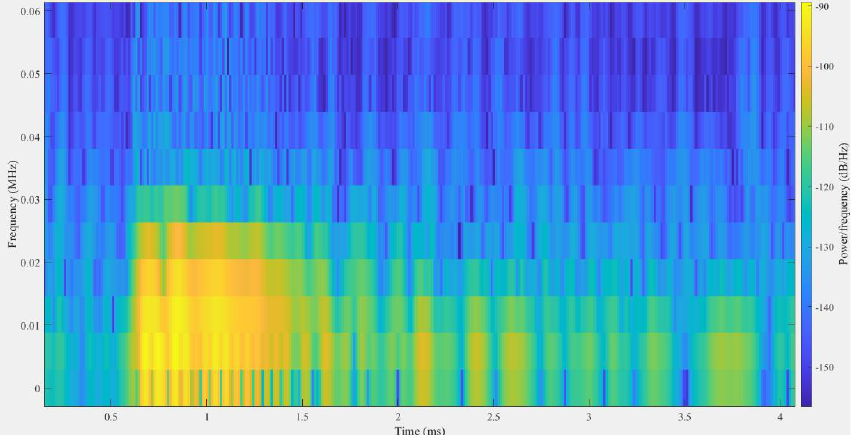
Figure 33. Time-frequency diagram of low frequency signal in S3 noise signal.